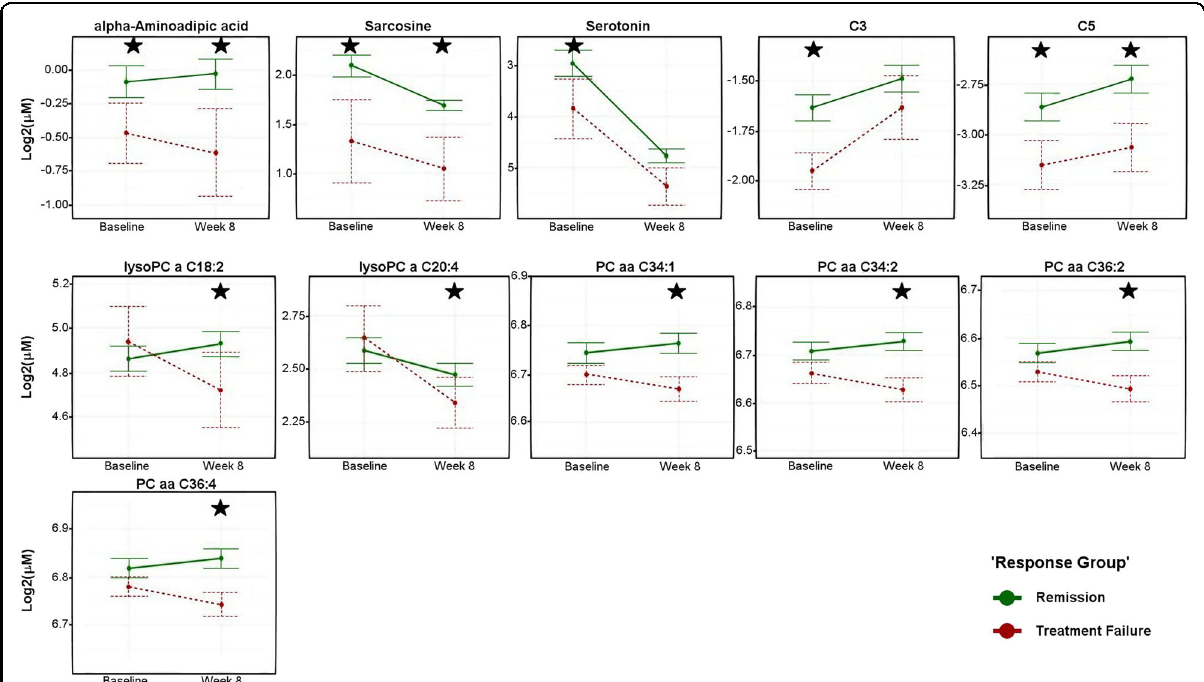
Fig. 4 Metabolite concentrations across visits by response group. Levels (log2 transformed) of metabolites at pre-treatment and 8 weeks post- treatment. Green lines indicate participants who remitted and red lines indicate participants who failed to respond to the treatment at the end of therapy. Asterisks indicate the statistical signi fi cance of mean differences between the two groups (unadjusted P < 0.05). Error bars represent the standard error of the means. Black stars represent statistical signi fi cance at the visit. P values were obtained from linear mixed-effect models corrected for age, sex, antidepressant, and 17-item Hamilton Rating Scale for Depression scores. PC phosphatidylcholines, LysoPC lysophosphatidylcholine. Metabolite abbreviations are spelled out in Supplementary Table